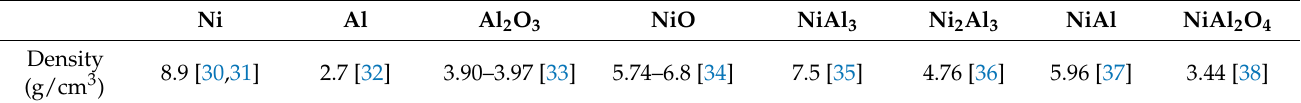
Table 1. Density of raw materials and observed